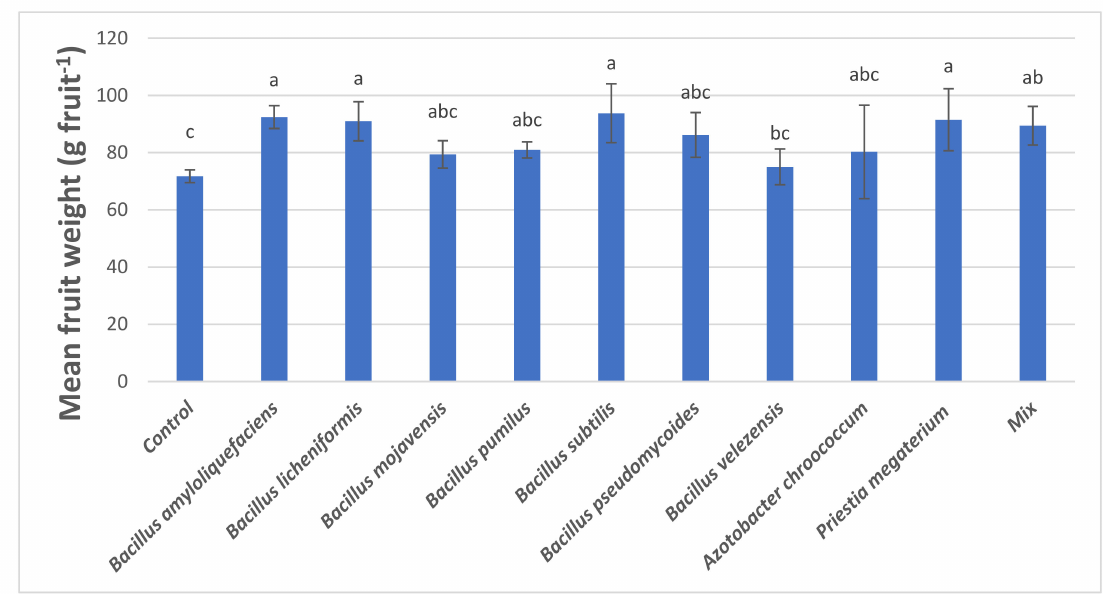
Figure 2. Mean fruit weight of harvested tomatoes. Mix: Mix of Priestia megaterium B004 + Azotobacter chroococcum A004 with zeolite as a carrier. Means followed by same letter for treatments are not significantly different according to Duncan test ( p < 0.05). Values presented are mean values of three replicates ± standard deviation. F value of ANOVA: 2.585 (Significance level: p <